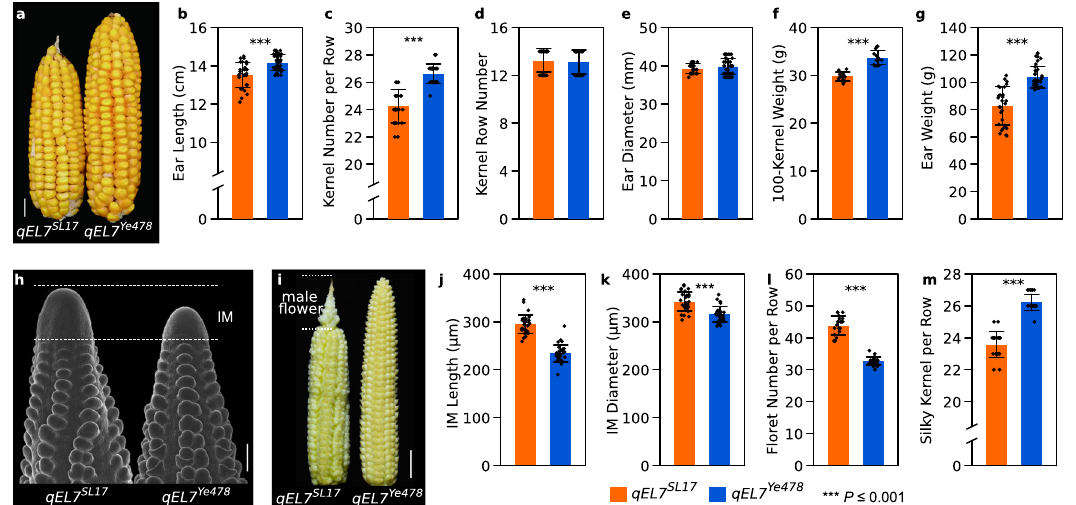
Fig. 1 qEL7 moderates grain yield by affecting the proportion of fl orets that developed into seeds during ear development. qEL7 Ye478 plants make longer ear with more kernels per row ( a , scale bar = 1 cm), smaller IM ( h , scale bar = 200 µ m), and higher fl oret fertility ( i , scare bar = 2 cm) than that in qEL7 SL17 . Phenotypes of ear length ( b , p = 1.82 × 10 − 6 ), kernel number per row ( c , p = 1.03 × 10 − 15 ), kernel row number ( d , p = 0.30), ear diameter ( e , p = 0.10), 100-kernel weight ( f , p = 7.42 × 10 − 10 ) and ear weight ( g , p = 1.90 × 10 − 11 ) in qEL7 SL17 and qEL7 Ye478 ; n = 39 and 32, respectively. IM length ( j , p = 5.92 × 10 − 19 ) and diameter ( k , p = 1.04× 10 − 7 ) of qEL7 SL17 and qEL7 Ye478 ; n = 31 for both. Floret number per row ( l , p = 1.24 × 10 − 20 ) and silky kernels per row ( m , p = 9.04 × 10 − 17 ) of the immature ears before pollination in qEL7 SL17 and qEL7 Ye478 ; n = 21 and 24, respectively. For b − g and j − m data are presented as means ± SD. *** p -value ≤ 0.001, from a two-tailed, two-sample t-test; orange bar, qEL7 SL17 ; blue bar, qEL7 Ye478 . For h , ears from fi ve plants of each genotype were imaged by scanning electron microscope. n is the number of ears examined in ( b − g ) and ( j − m lines ( ACO2-OE1 , OE2, and OE3 ) (Fig. 3e − h) using maize Ubi- quitin promoter-driven ZmACO2 constructs ( pUBI:ZmACO2 ).